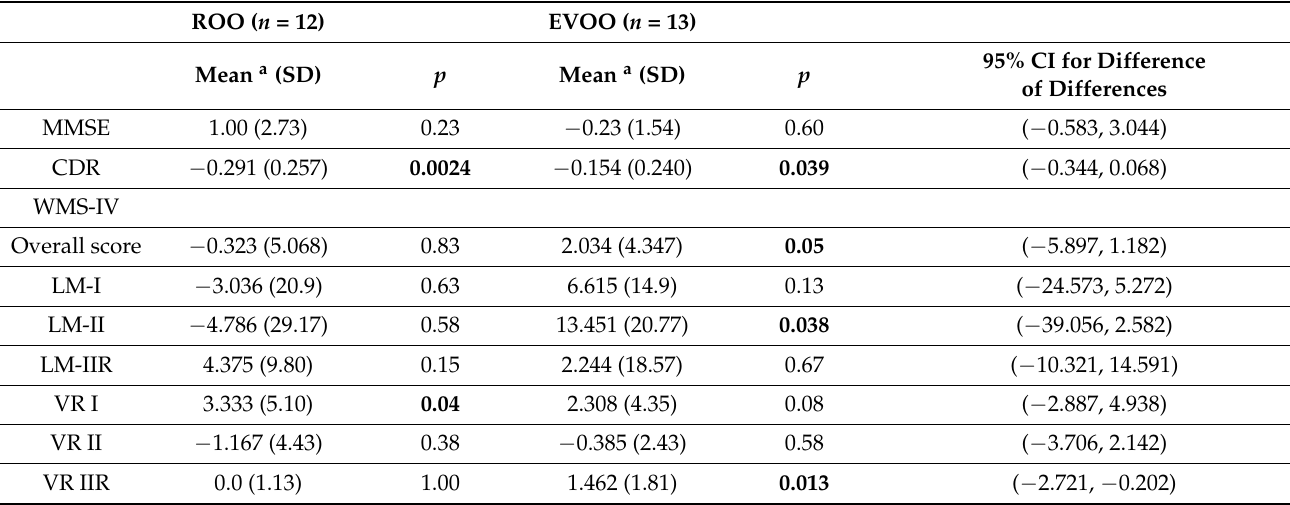
Table 4. Changes in MMSE, CDR, and WMS-IV scores after 6 months of olive oil